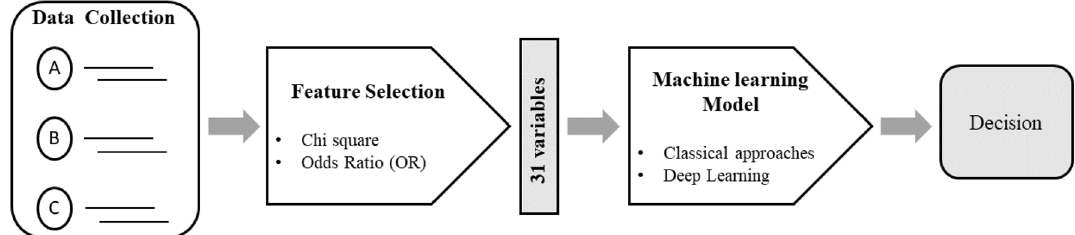
Figure 1. Automatic system for predicting smartphone